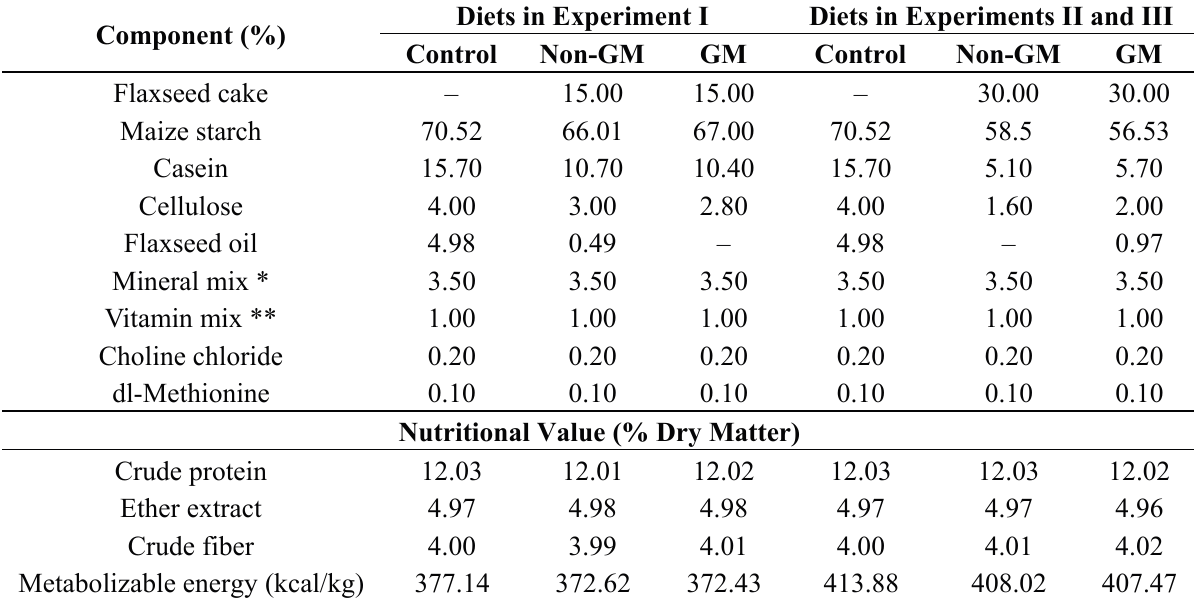
Table 5. Composition and nutritional value of